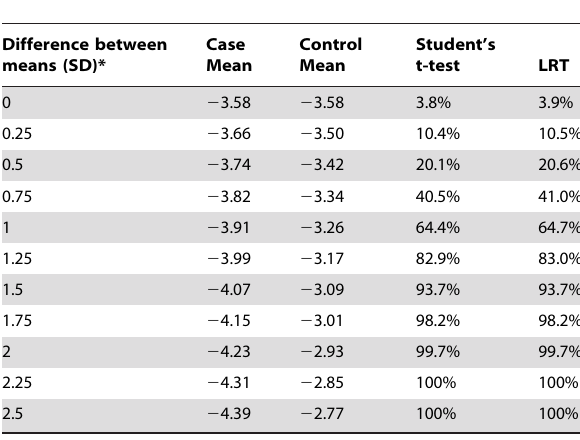
Table 2. Results for equal mean expression intensities but the probability of expression differs between